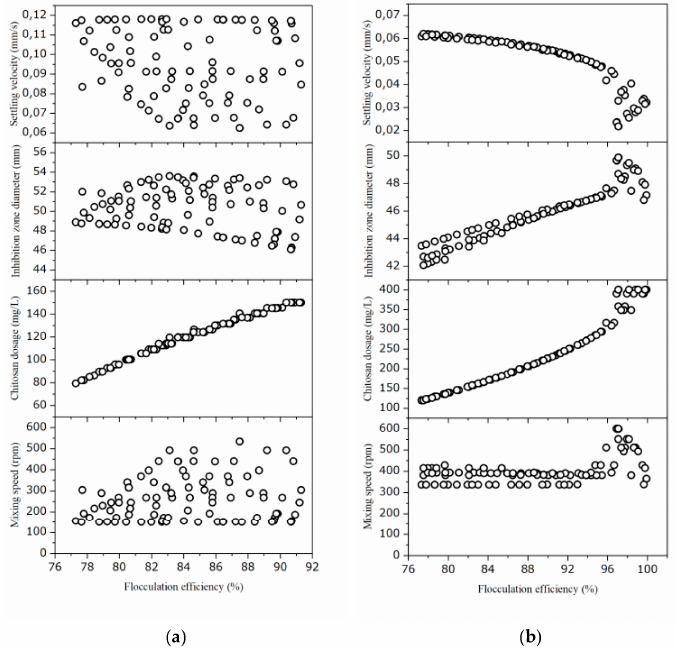
Figure 4. The Pareto front plot and decision space of the optimal solution set obtained from the multi-objective genetic algorithm with ( a ) cheese whey effluent and ( b ) winery flotation effluent.